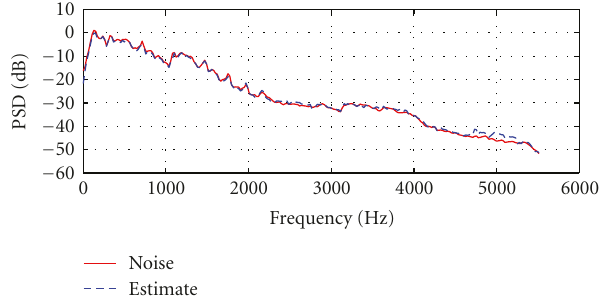
Figure 7: Estimated and actual noise PSD for mic. 2 at car speed of 140km/h.